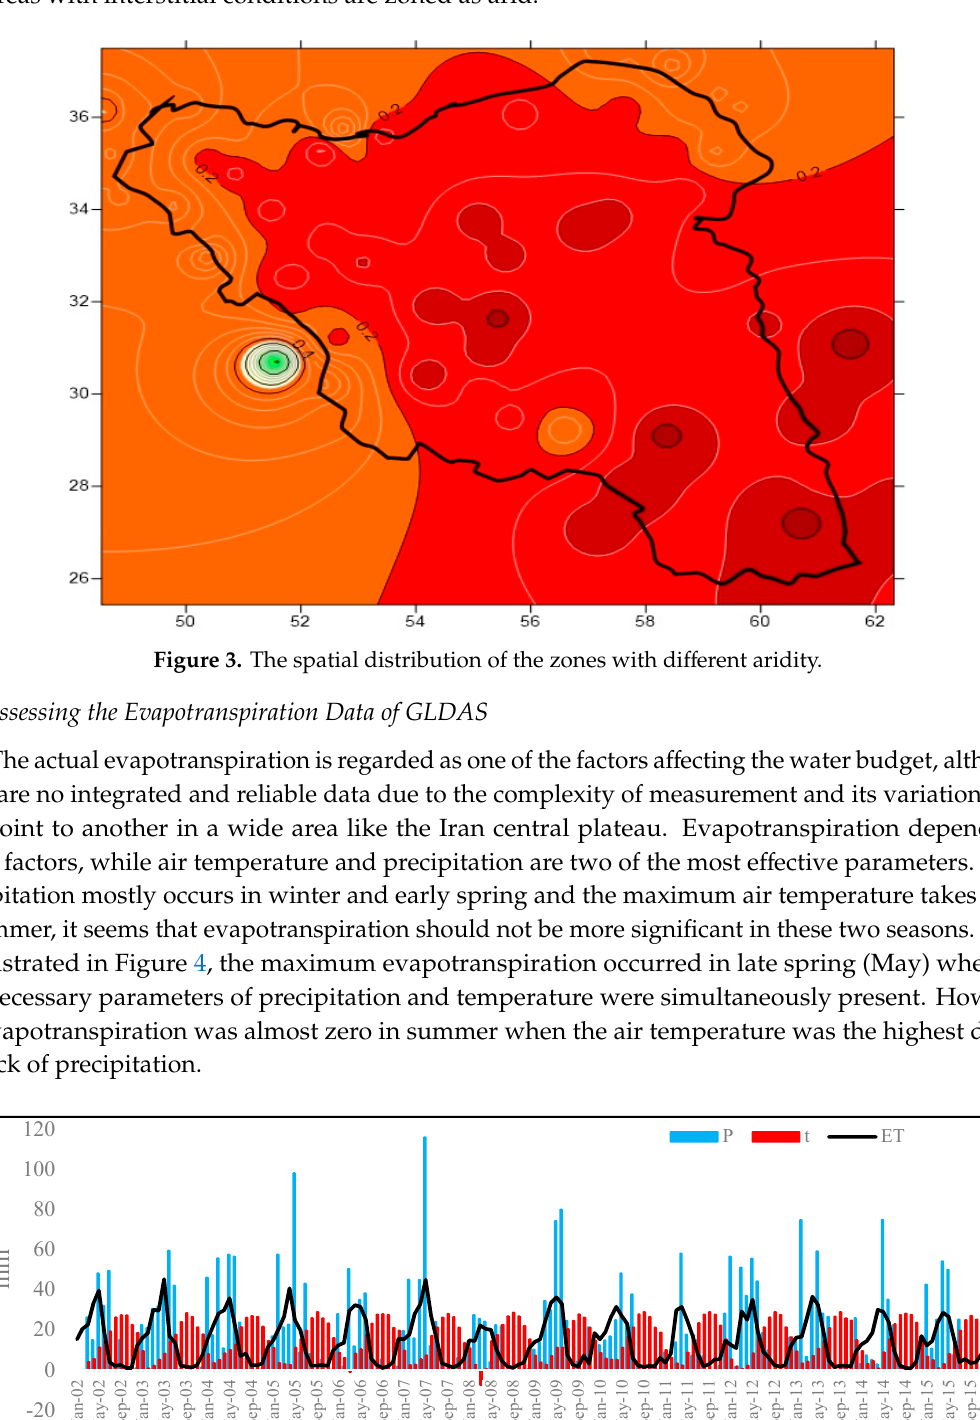
-20 Figure 4. The precipitation, temperature, and evapotranspiration anomalies from 2002 to 2016.